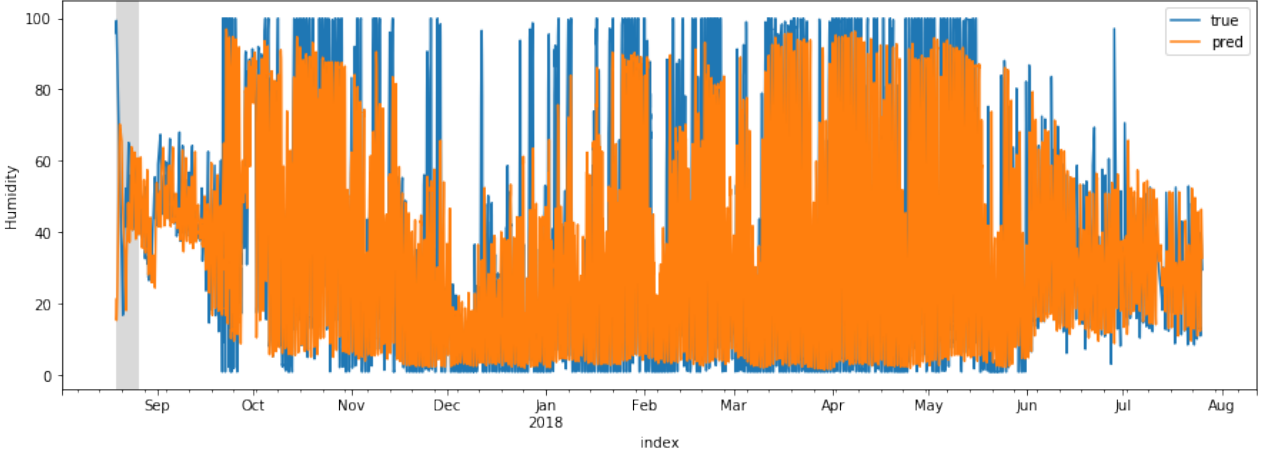
Figure 7. Plot of true (blue curve) and predicted (orange curve) readings of humidity.